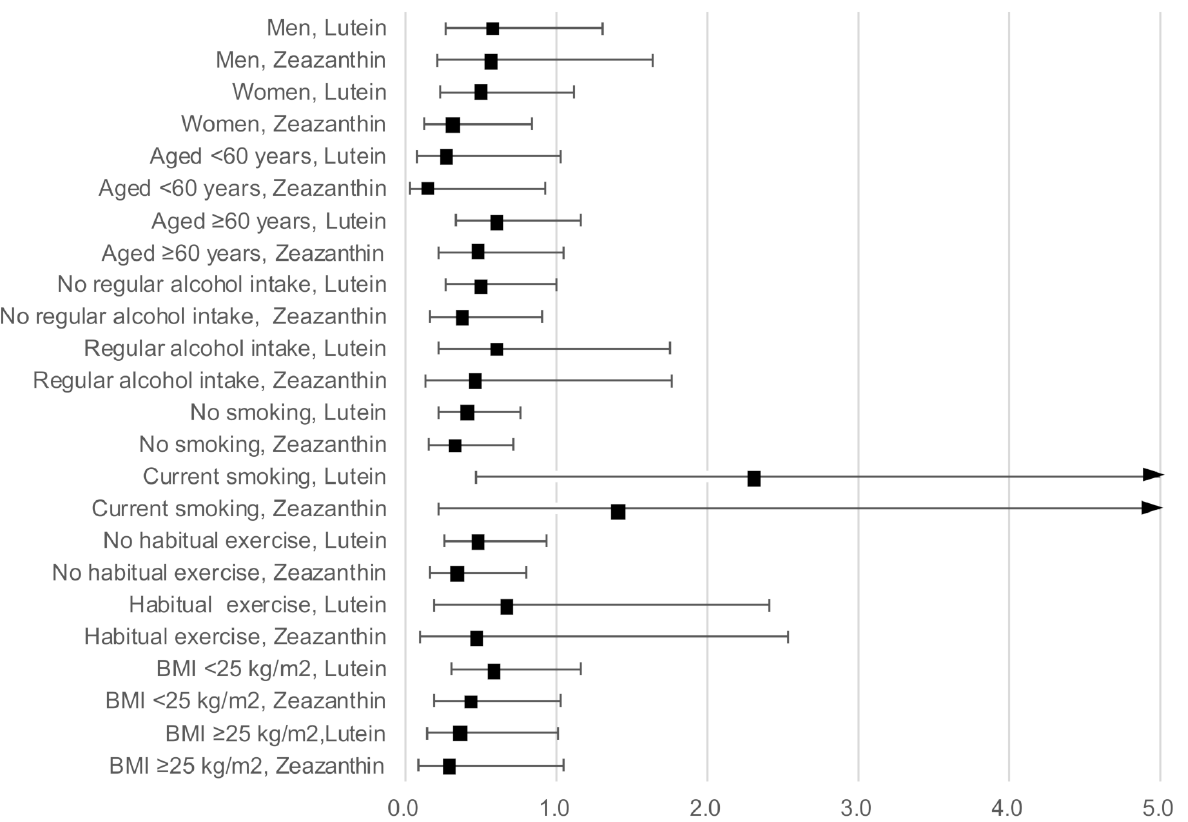
Figure 2. Odds ratios and 95% confidence intervals for a high hs-CRP level with lutein and zeaxanthin concentrations as continuous variables stratified by sex, age, BMI, current smoking, regular